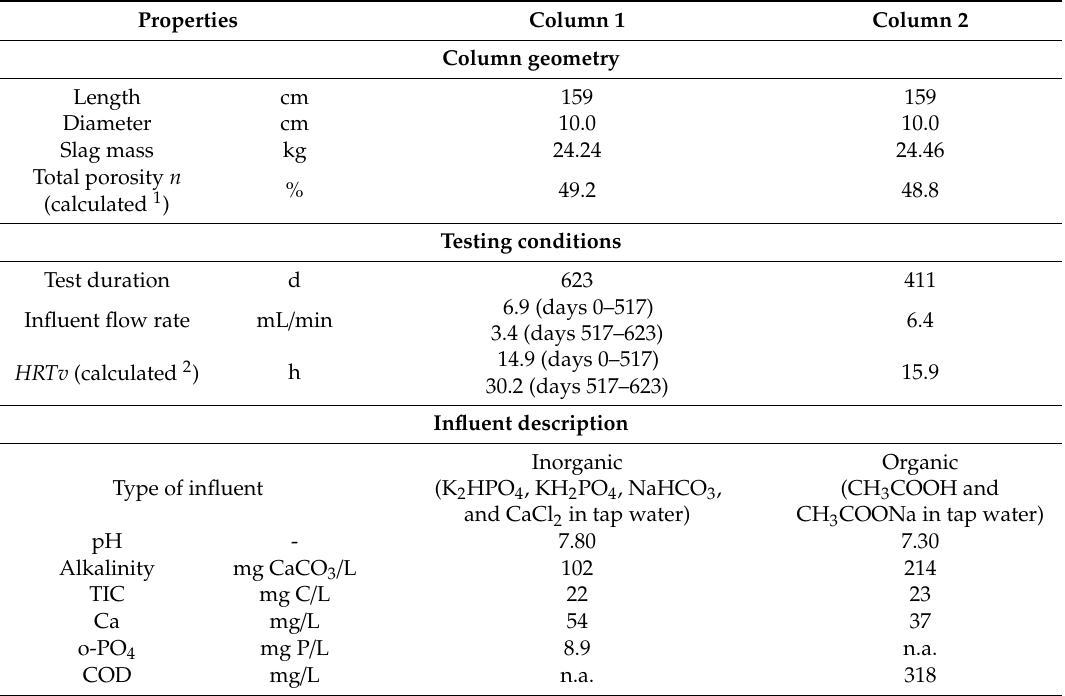
Table 1. Description of column